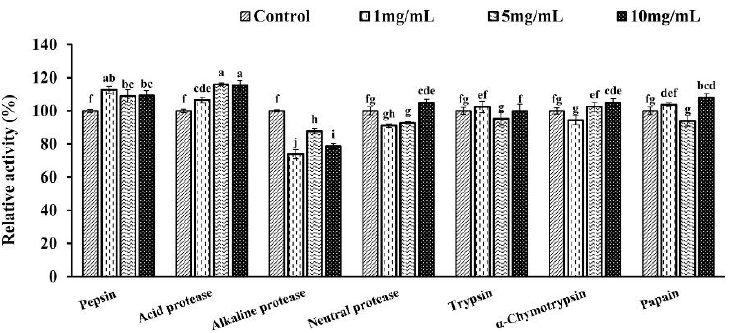
Figure 5. The resistance of ORG to various proteases. Result represents the mean ± SD ( n = 3). Statistical significance is indicated by different letters in columns as assessed by two-way ANOVA ( p < 0.05). Different lowercase letters (a, b, c, d, e, f, g, h, i, j) indicate statistical significance ( p < 0.05).